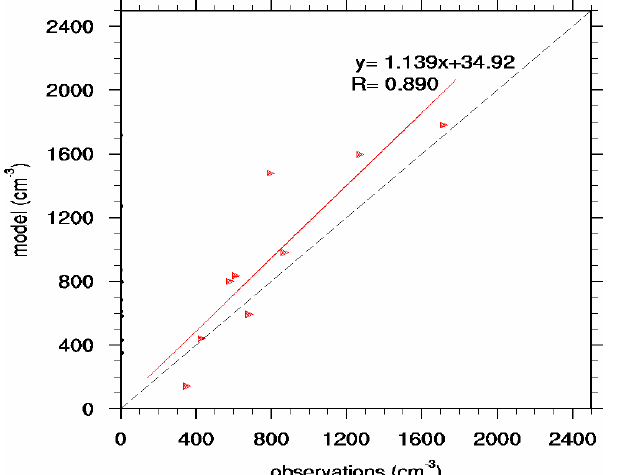
Fig. 9. Comparison of aircraft measurements of natural particles with modeled dust and salt concentrations inside the dust layer (be- low 2km). The red line indicates the linear regression line while the dotted line indicates the y = x line.